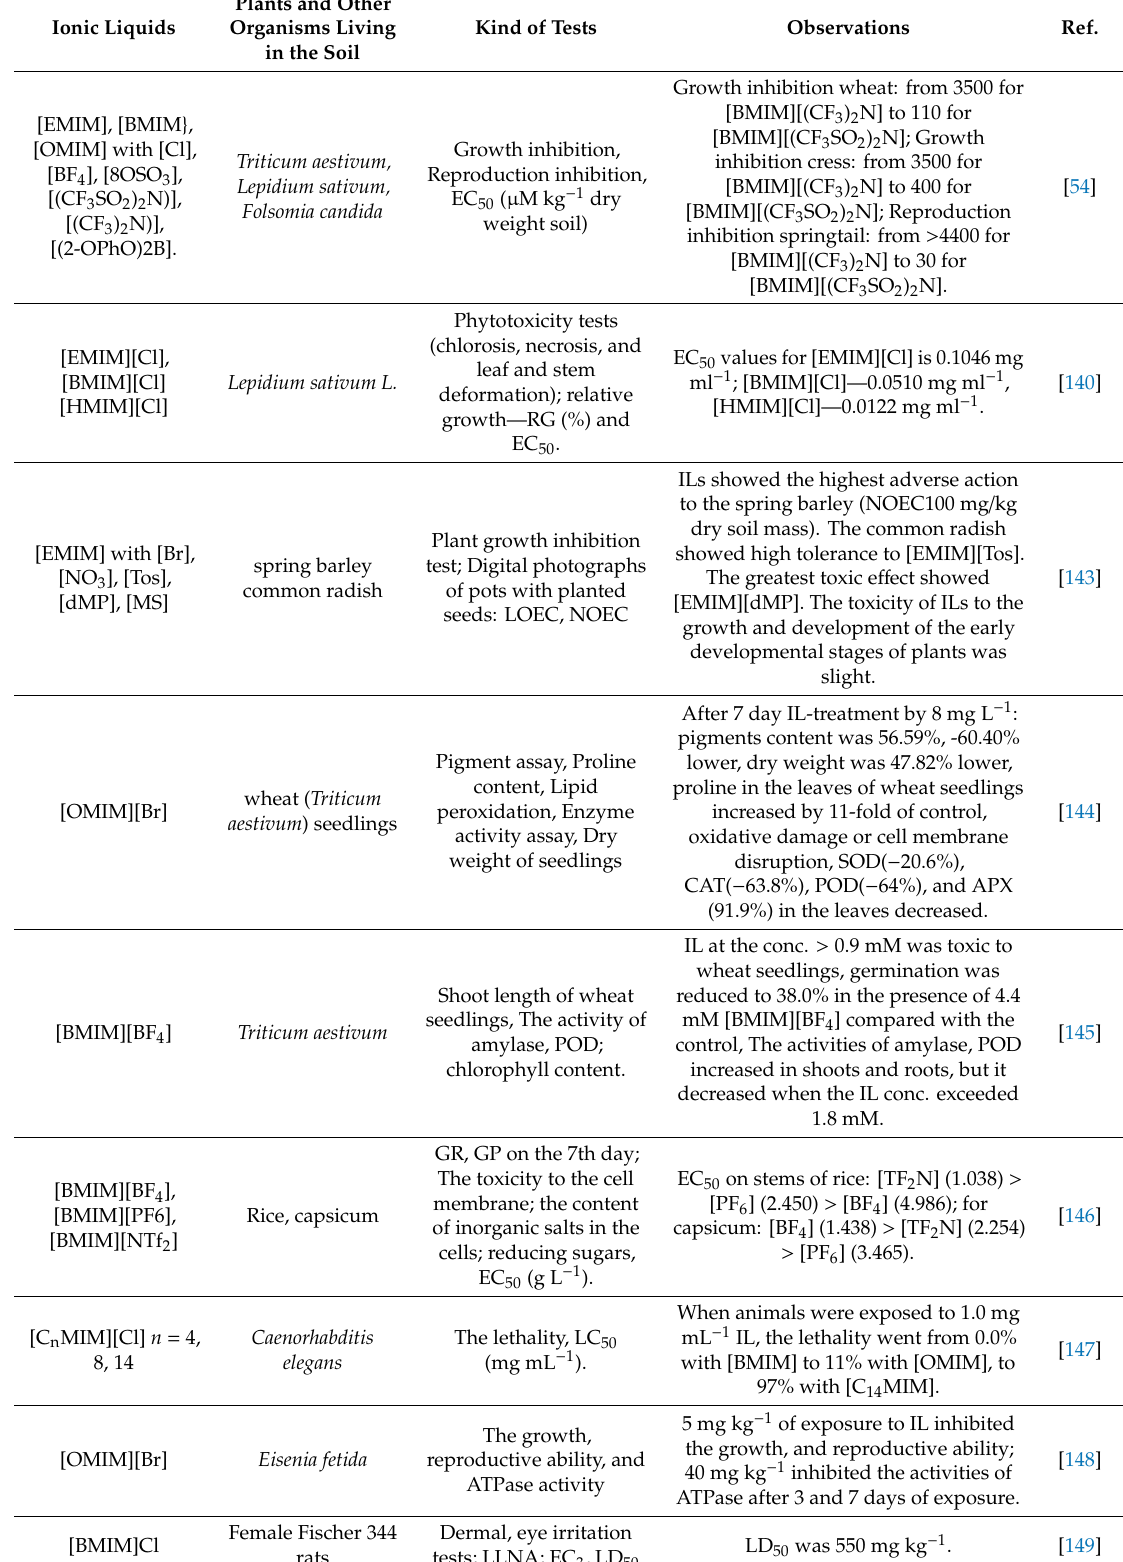
Table 3. Toxicity of ionic liquids against plants and organisms living in the